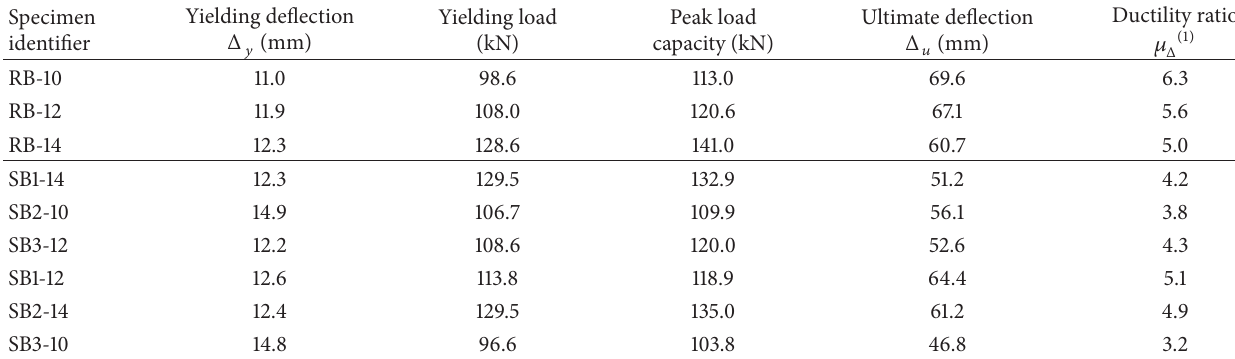
Table 4: Test results of the specimens.